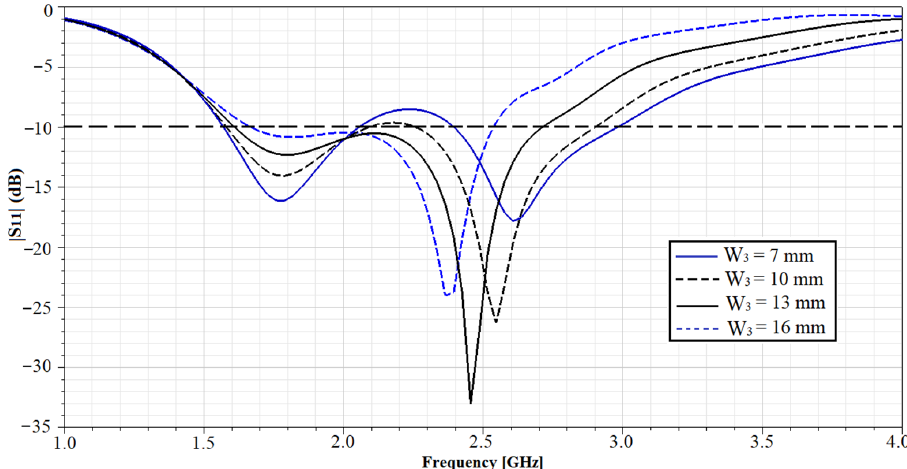
11 | with respect to the length L 2.